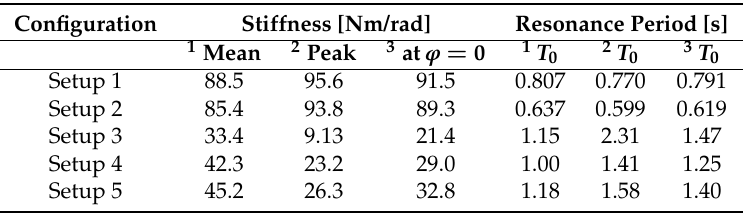
Table 6. Hydrostatic stiffness estimated for the different system configurations from slow forced oscillations in calm water. The values referred to as mean are computed as the average over the rotation angle interval [ − 0.05, 0.05]rad. The resonance period estimated in the three last columns refer to the corresponding stiffness values in the three first columns. Note that the peak values refer to a maximum value for setups without WaveSpring (Setups 1 and 2), and a minimum value for setups with WaveSpring (Setups 3–5), cf. Figure